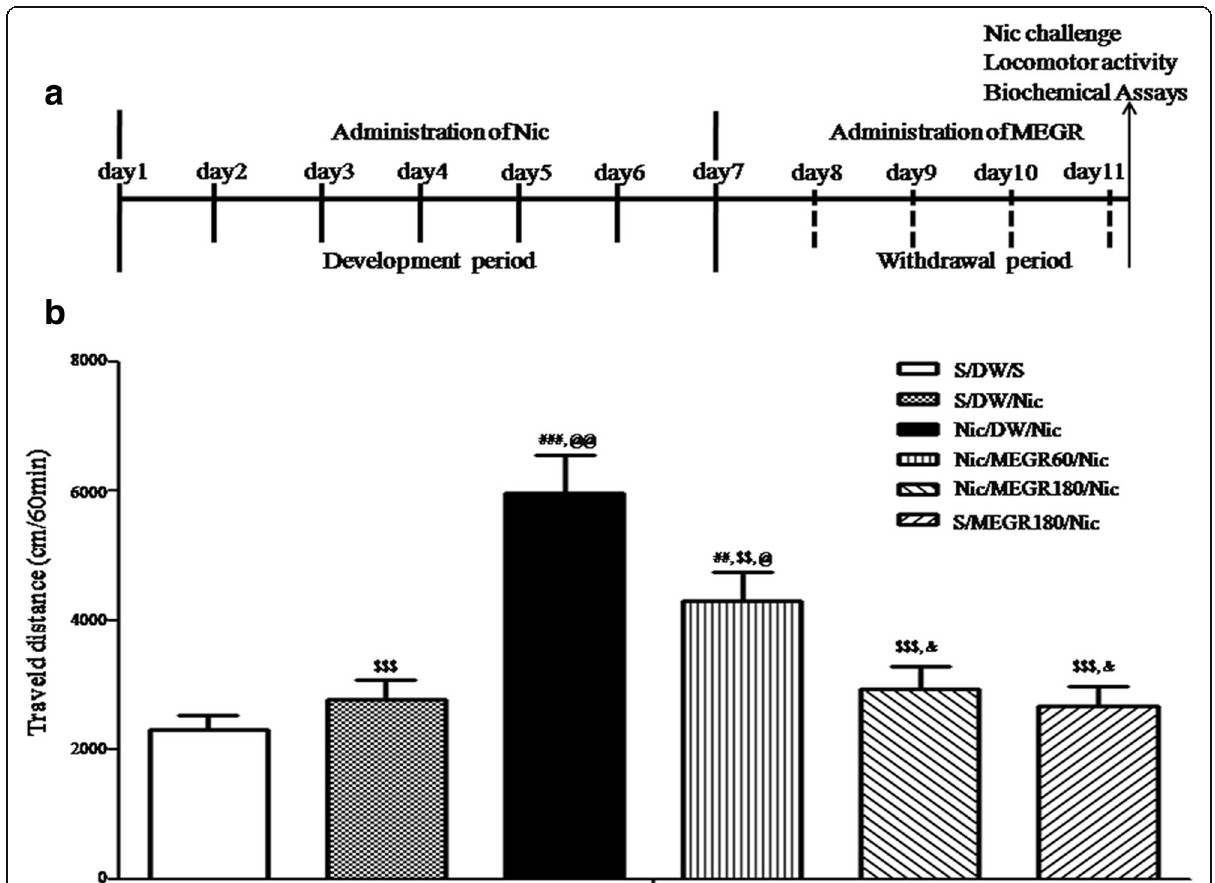
Fig. 1 a Time schedule for nicotine-induced locomotor sensitization. Rats received nicotine (Nic) administrations (0.4 mg/kg s.c., twice a day) for 7 consecutive days, underwent 4 days of withdrawal, and then challenged with the same dose of Nic to induce locomotor sensitization; during the withdrawal period, the rats were orally administered MEGR (60 or 180 mg/kg/day, 4 times). b Effects of MEGR on Nic-induced locomotor sensitization in rats. Repeated Nic administrations induced a significant locomotor sensitization, which was inhibited by MEGR treatment. All data are expressed as means ± SEM ( n =7). S: saline, DW: distilled water, MEGR: methanol extract of G. radix, MEGR60: 60 mg/kg/day MEGR, MEGR180: 180 mg/kg/day. ## P <0.01, ### P <0.001 versus S/DW/S group; $$ P <0.01, $$$ P <0.001 versus Nic/DW/Nic group; @ P < 0.05, @@ P <0.01, versus S/DW/Nic group; & P <0.05 versus Nic/MEGR60/Nic group (one-way ANOVA followed by Newman-Keuls post-hoc